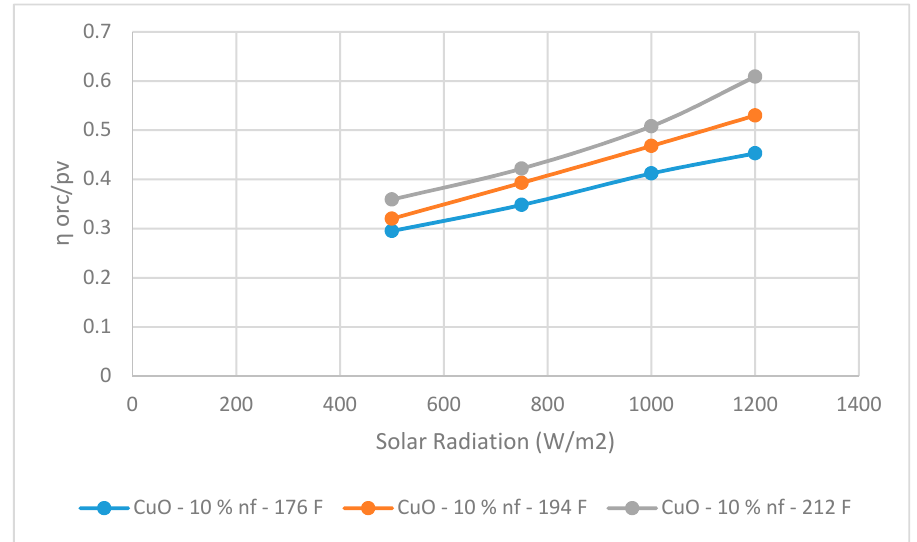
Figure 9. Hybrid system efficiency for Nanofluid CuO different temperatures and 10% volumetric concentration.